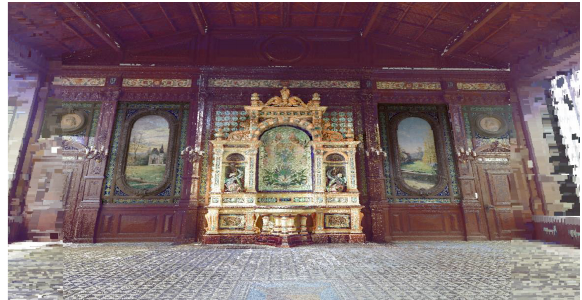
Figure 8. Immersion in virtual reality in the Winter